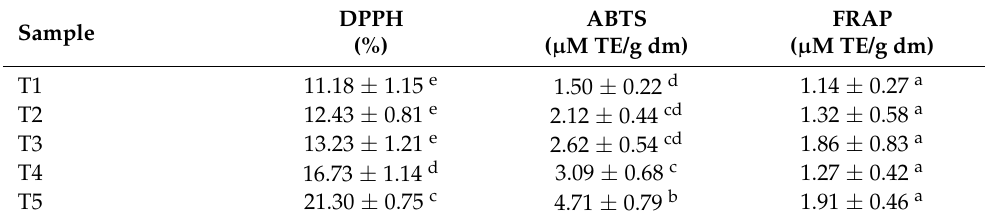
Table 3. Antioxidant activity of corn snacks 1 : 100% CM (T1), 80% CM–20% UMF (T2), 50% CM–50% UMF (T3), 80% CM–20% OAF (T4), and 50% CM–50% UMF (T5), as measured in terms of DPPH, ABTS-radical scavenging activity, and FRAP-activities 2 .